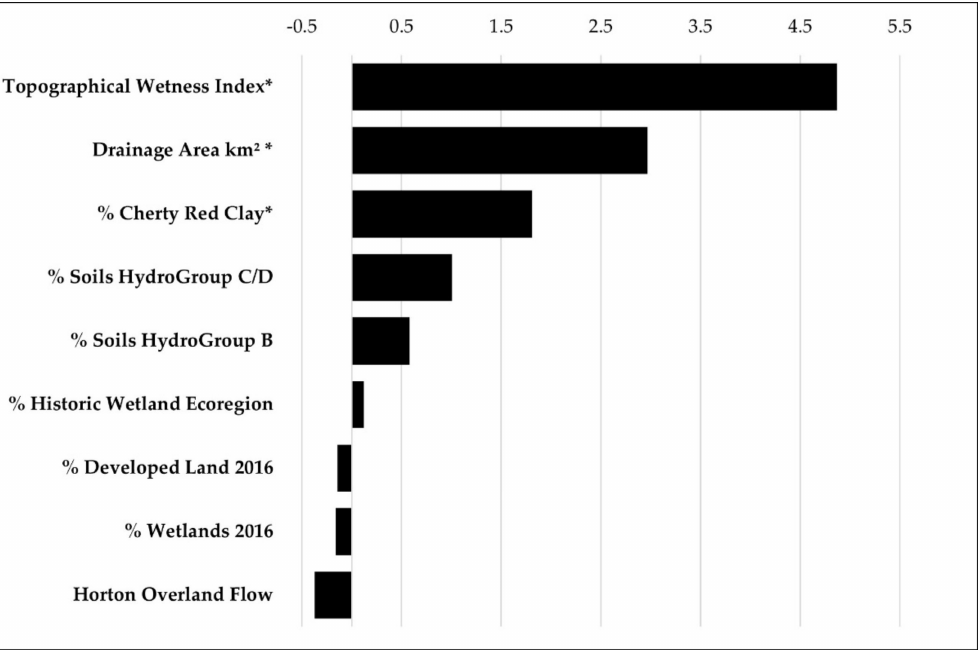
Figure 10. Z-scores of variables determined by hierarchical partitioning. * Denotes variables significant at 95% confidence